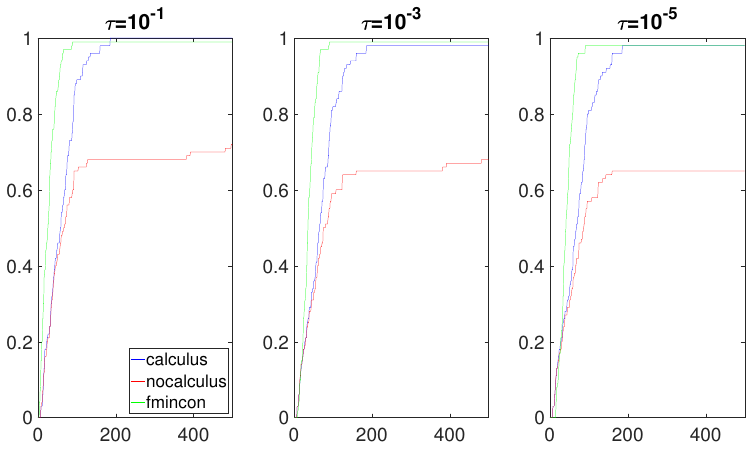
, f 1 is a linear function, and f 2 is a quadratic function. f 2